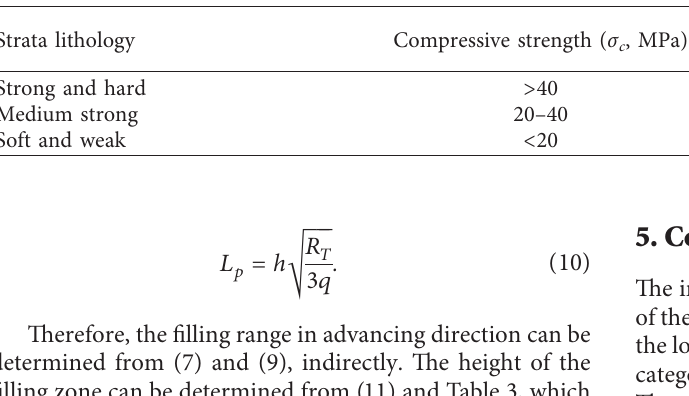
Table 3: Coefficients for average height of caving zone [27,